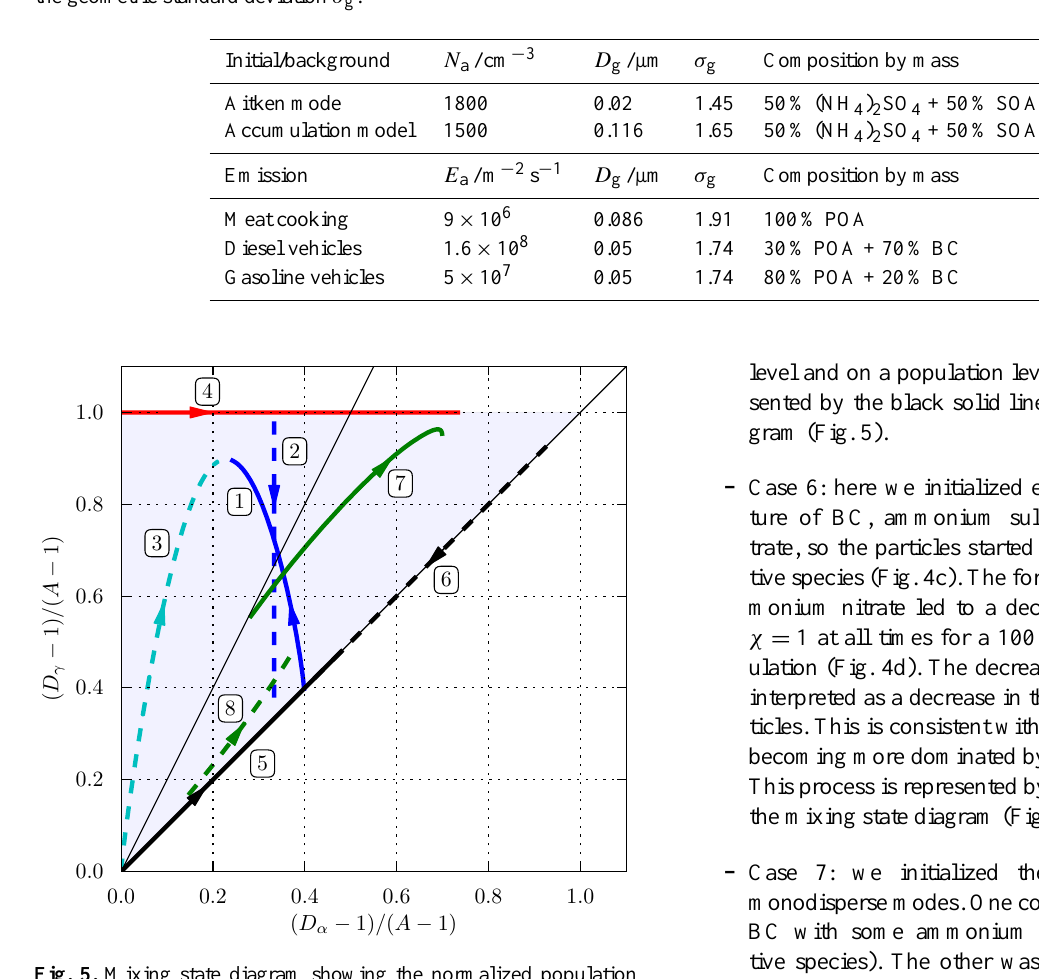
Table 7. Initial, background, and emission aerosol populations for the urban plume case, giving the number concentration N a or area rate of emission E a as appropriate. The aerosol population size distributions are log-normal and defined by the geometric mean diameter D g and the geometric standard deviation σ g .